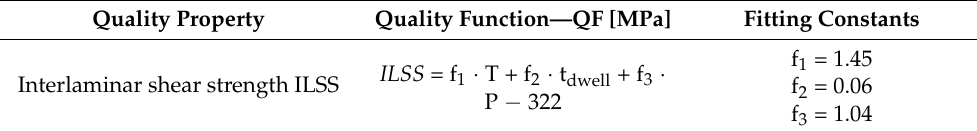
Table 2. The QF derived for the autoclave process. Quality